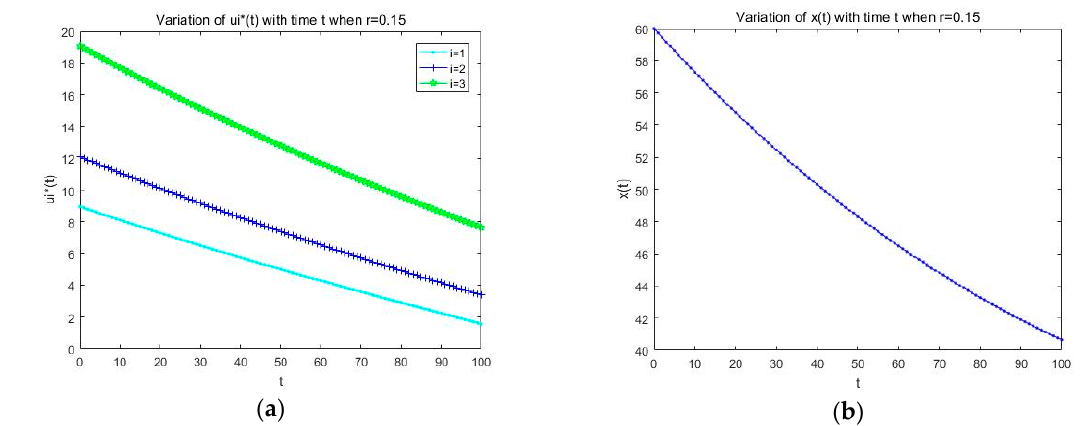
Figure 3. ( a ) Variation of 𝑢 (cid:3036)∗ (𝑡) with time t for the open loop solution; ( b ) variation of 𝑥(𝑡) with time t for the open loop solution.